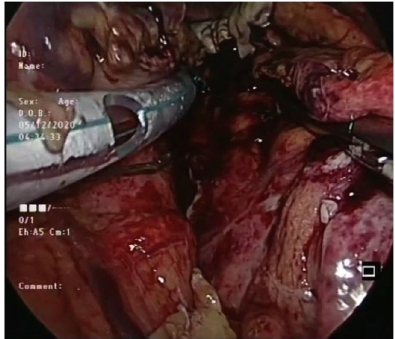
Figure 3: Drain placed into the cavity of the